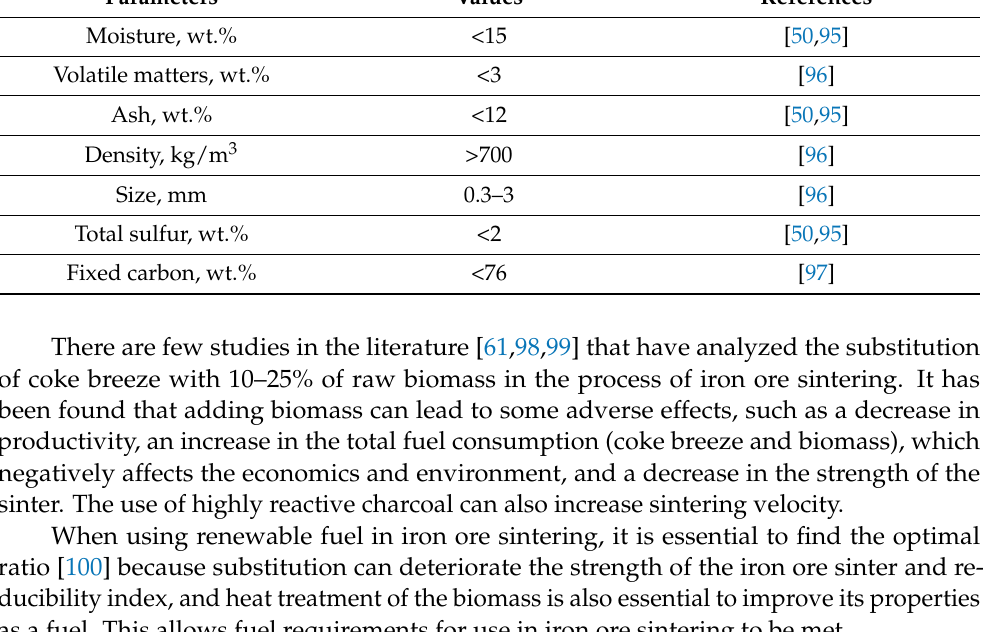
Table 4. Main properties of coke breeze for iron ore sintering.